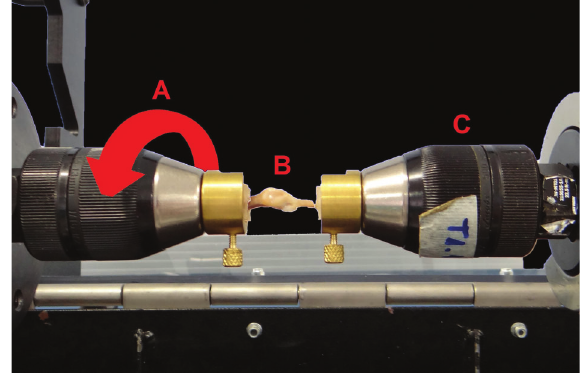
Figure 2. Positioning of the tibia to test the torsion. A : mobile device, arrow indicates the orientation of the torsion; B : tibia; C : fi xed device.